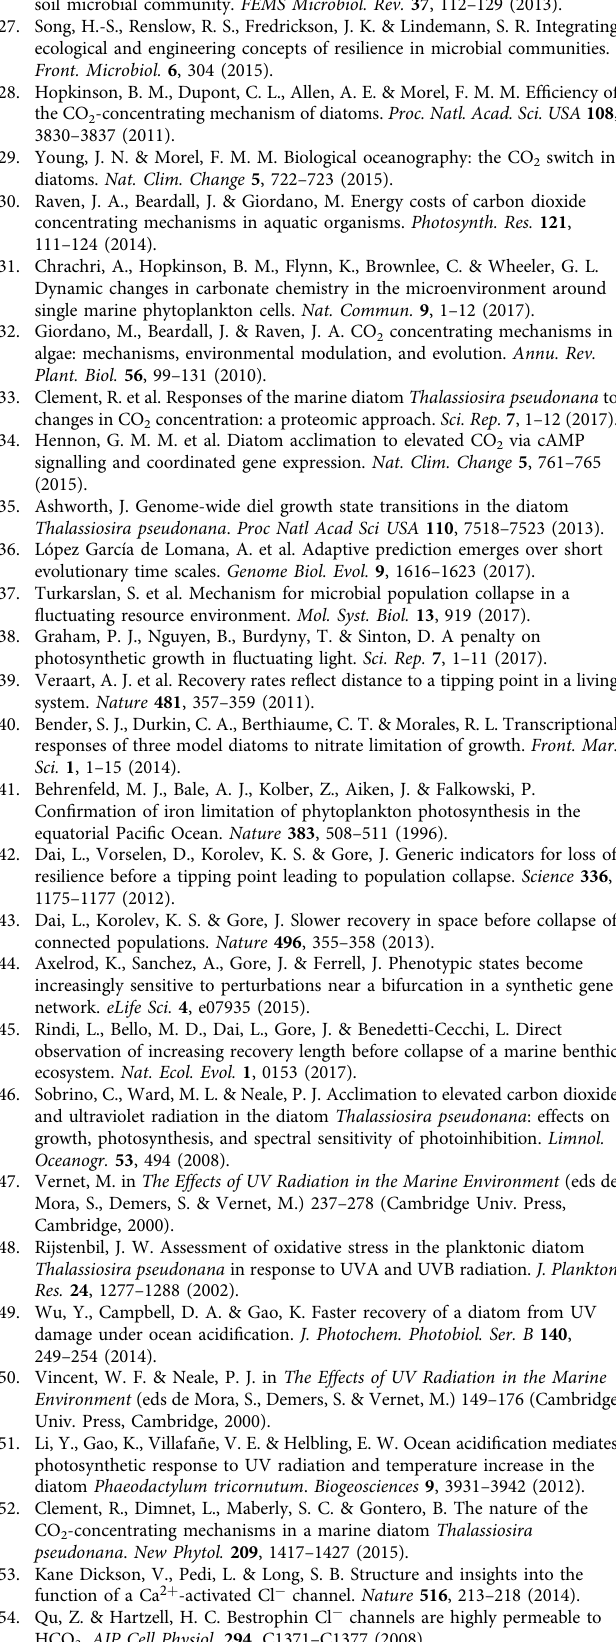
Data availability . All sequences supporting the fi ndings of this study are publicly available from the National Center for Biotechnology (NCBI) Sequence Read Archive (SRA), accession code